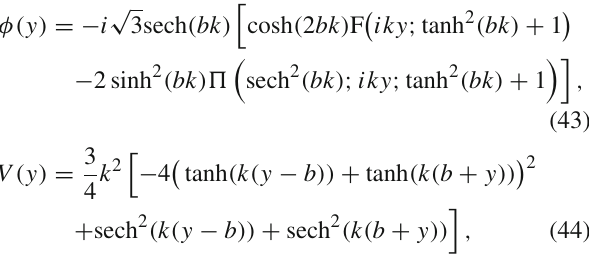
Fig. 1 Plots of the warp factor (42) and the scalar field (43), and the scalar potential V (φ)